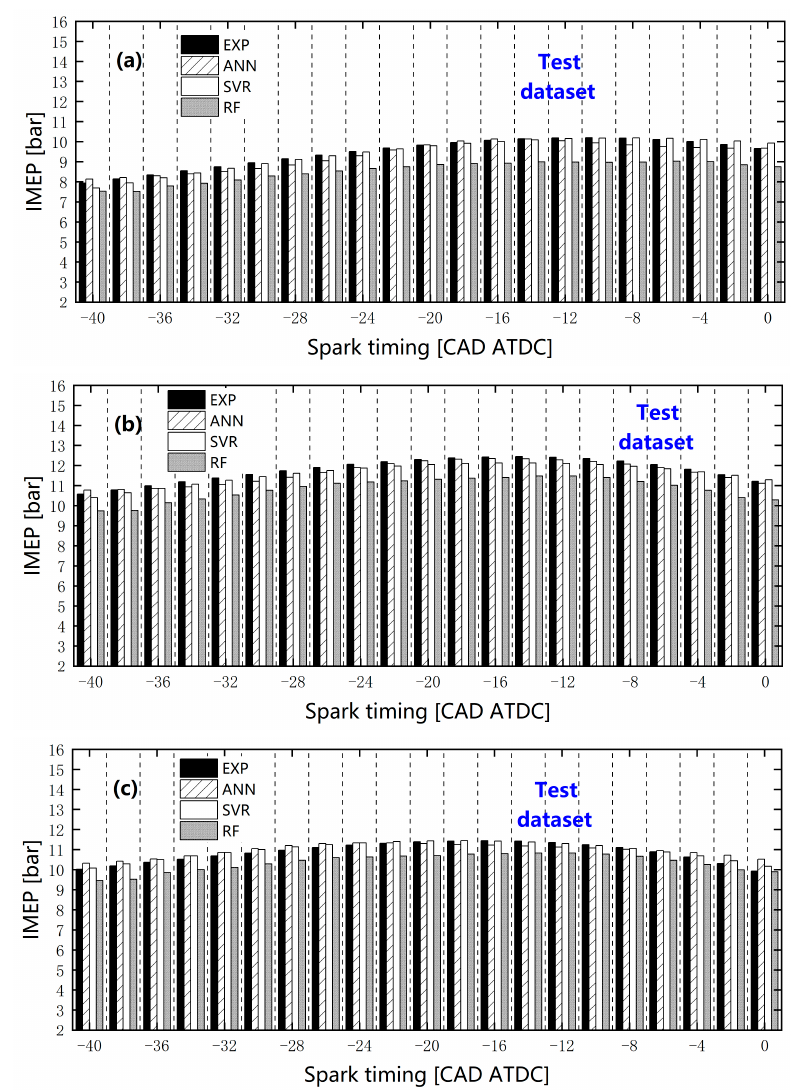
Figure 9. Comparison of predicted IMEP with actual values at high load: ( a ) low speed; ( b ) medium speed; ( c ) high speed.